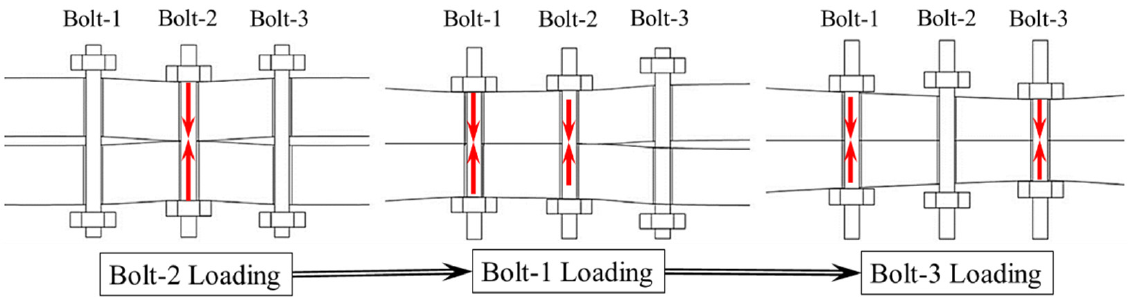
Figure 6. Schematic diagram of bolt elastic interaction.